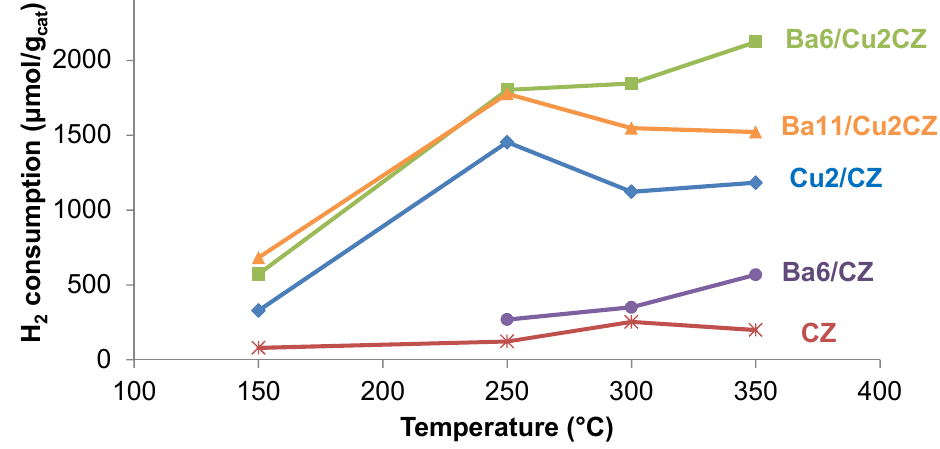
Figure 5. H 2 consumption in the reduction step (2000 ppm H 2 for 1 h) at several temperatures. A very low reducibility is observed for bare CZ below 500 ◦ C, as expected from the H 2 -TPR results reported elsewhere [48]. On the contrary, the reducibility of Cu2/CZ is very high at low temperatures, starting from around 150 ◦ C. This behavior agrees with the H 2 uptake estimated in the H 2 reduction phase (see Figure 5), where CZ consumes a very low amount of H 2 , and Cu-containing catalysts present higher consumptions. In all cases, the evolution of water is observed along with H 2 consumption, thus indicating that some catalyst reduction is taking place. Most of H 2 consumption can be correlated to H 2 O generation, but an accurate quantification of water is difficult and problematic in this case (as previously mentioned). In the H 2 -TPR results presented elsewhere [48], additional evidence is provided of the catalyst reduction that occurs when the temperature of H 2 feeding is high enough. On the other hand, a part of these consumptions is attributed to nitrite/nitrate reduction and can be associated with the NO x stored in the previous step, that being the copper-containing catalysts with higher consumptions. H 2 consumption does not increase linearly with temperature due to the creation of different populations of ad-NO x species at different temperatures as a function of this